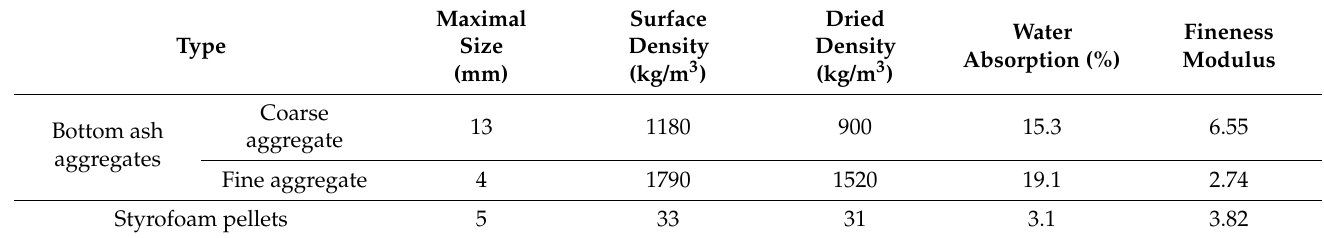
Table 1. Physical properties of bottom ash aggregates and Styrofoam pellets.